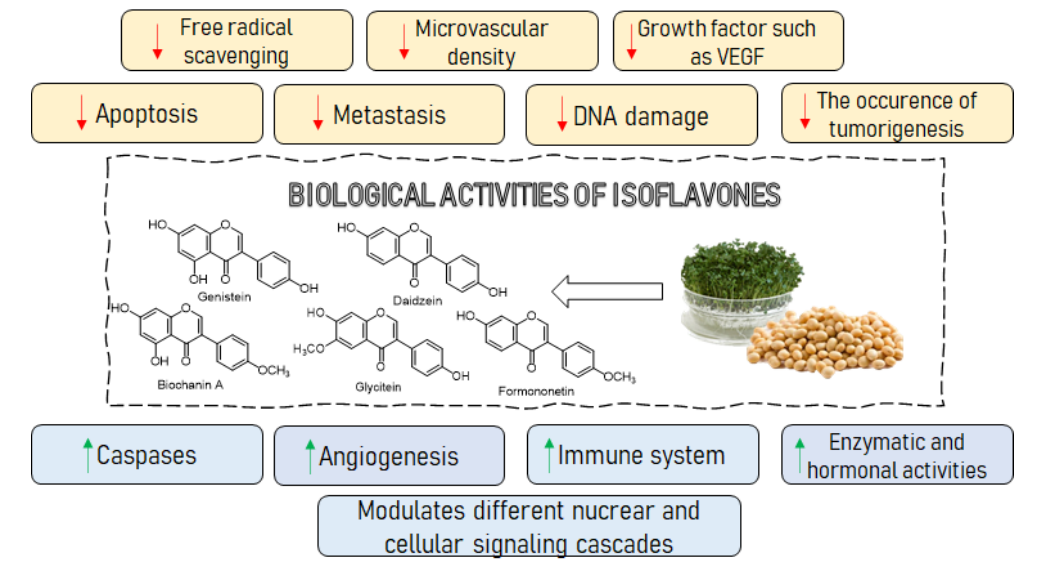
Figure 1. Biological activity of isoflavones. VEGF-vascular endothelial growth factor.